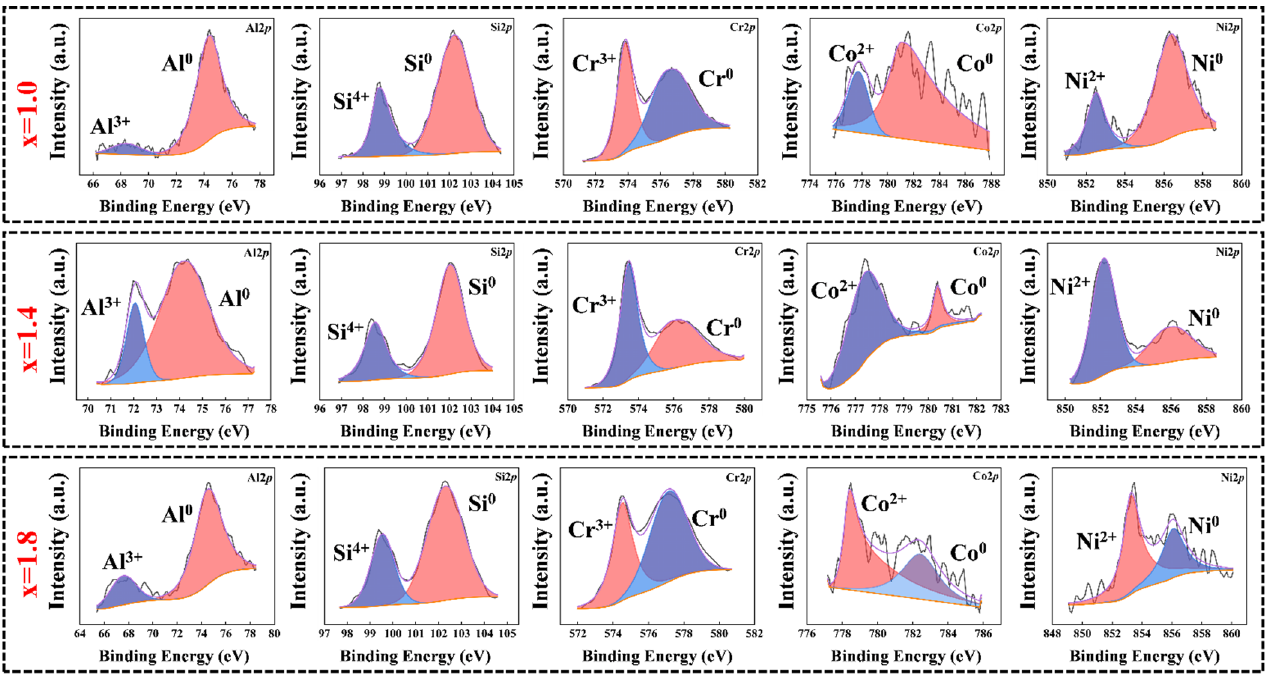
Figure 9. XPS fine spectra for AlSi 0.5 Cr x Co 0.2 Ni high entropy alloys (x = 1.0, 1.4, and 1.6).